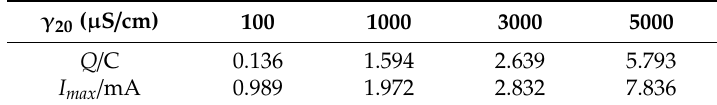
Table 3. Characteristic quantity of leakage current at di ff erent fog water conductivity rates (DC 3.2 kV, t = 8